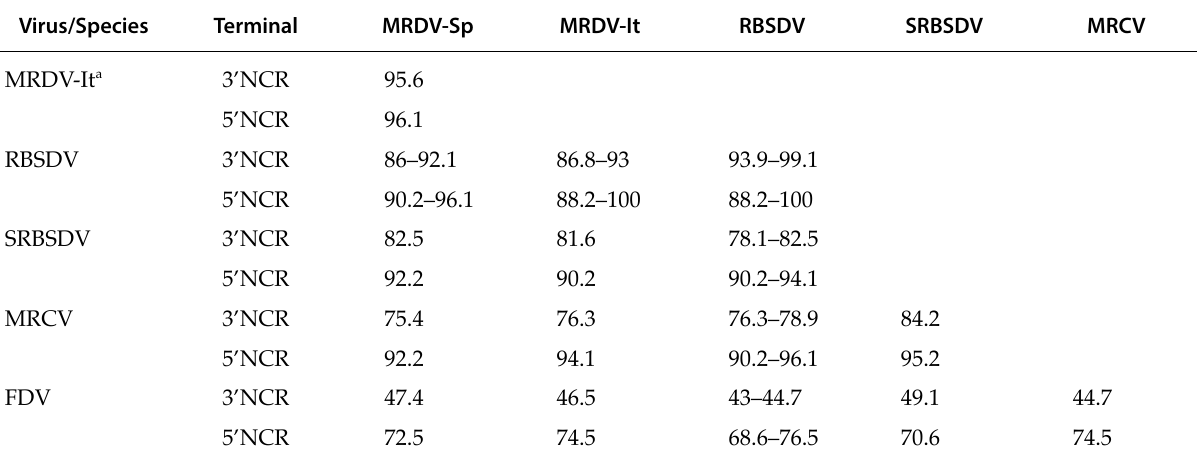
Table 4. Sequence identity (%) between species of the Fijivirus genus that infect maize at the 3’ and 5’ noncoding region of the segment